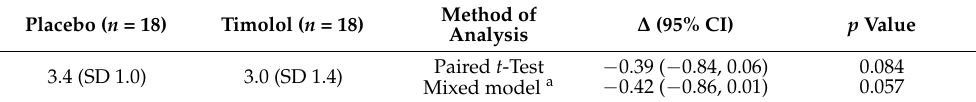
Table 3. Secondary endpoints.